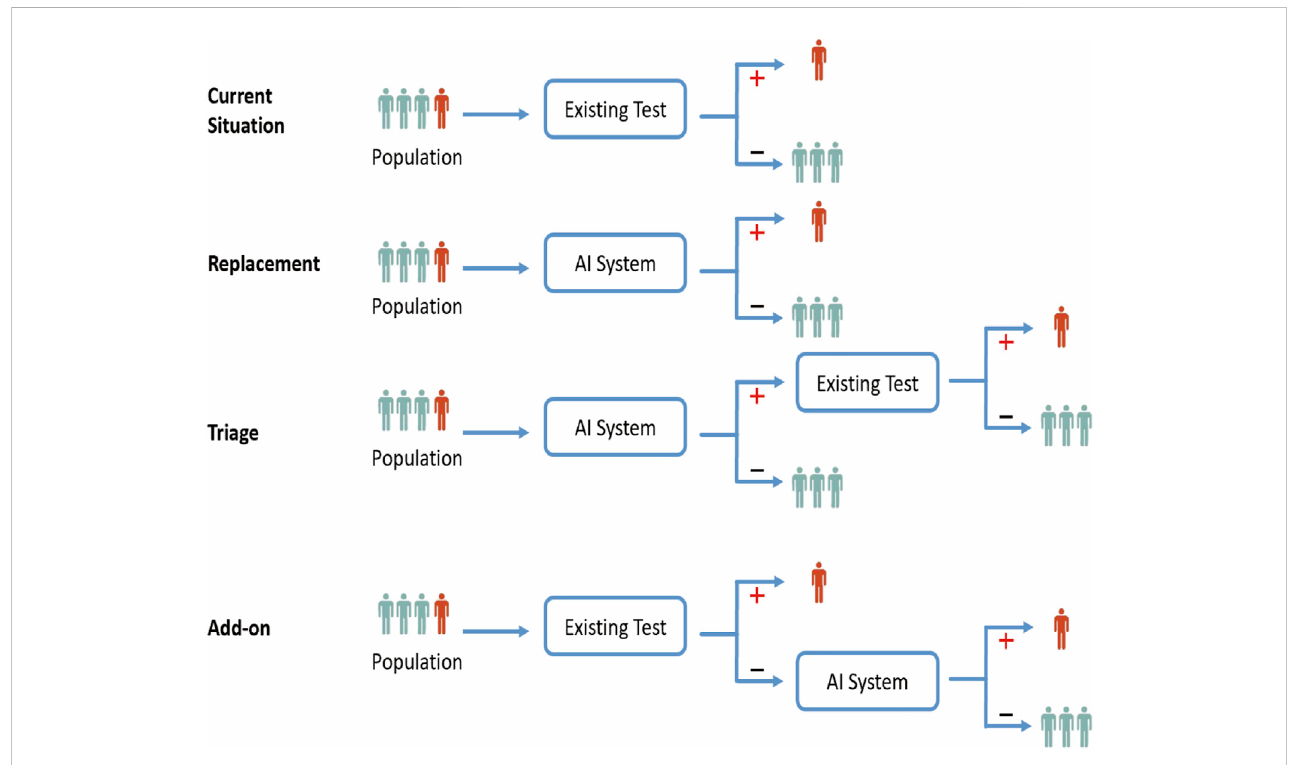
FIGURE 3 Three ways to integrate AI technology into existing clinical practices.